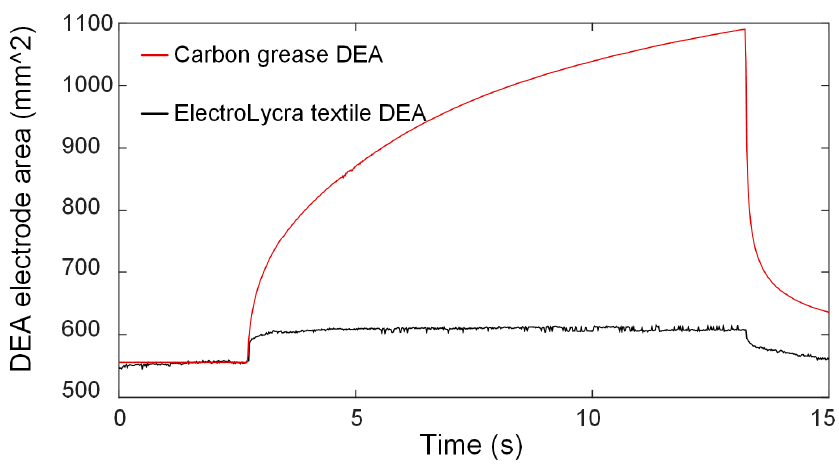
Figure 3. Dynamic DEA electrode area change comparison between carbon grease and ElectroLycra textile DEAs (6 kV applied for 10 s).